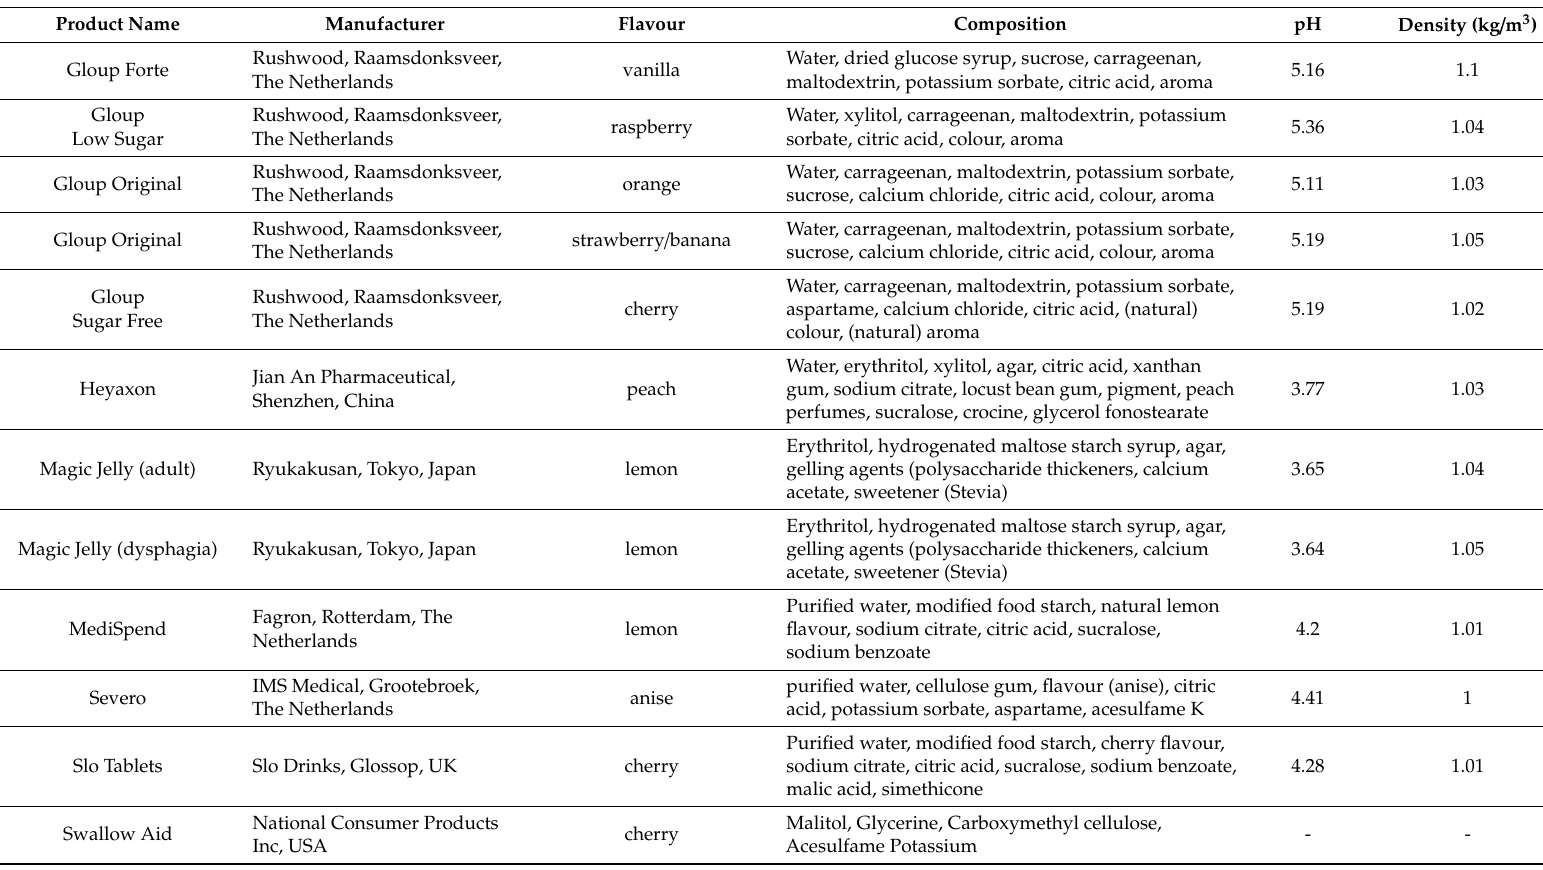
Table 1. Details of the twelve medication swallowing lubricants tested in this study. Flavour and composition details were taken from the product container; pH and density were measured at room temperature (24 ◦